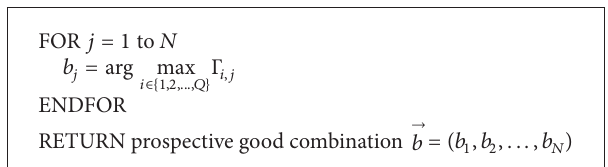
Algorithm 3: Calculation of prospective good combination